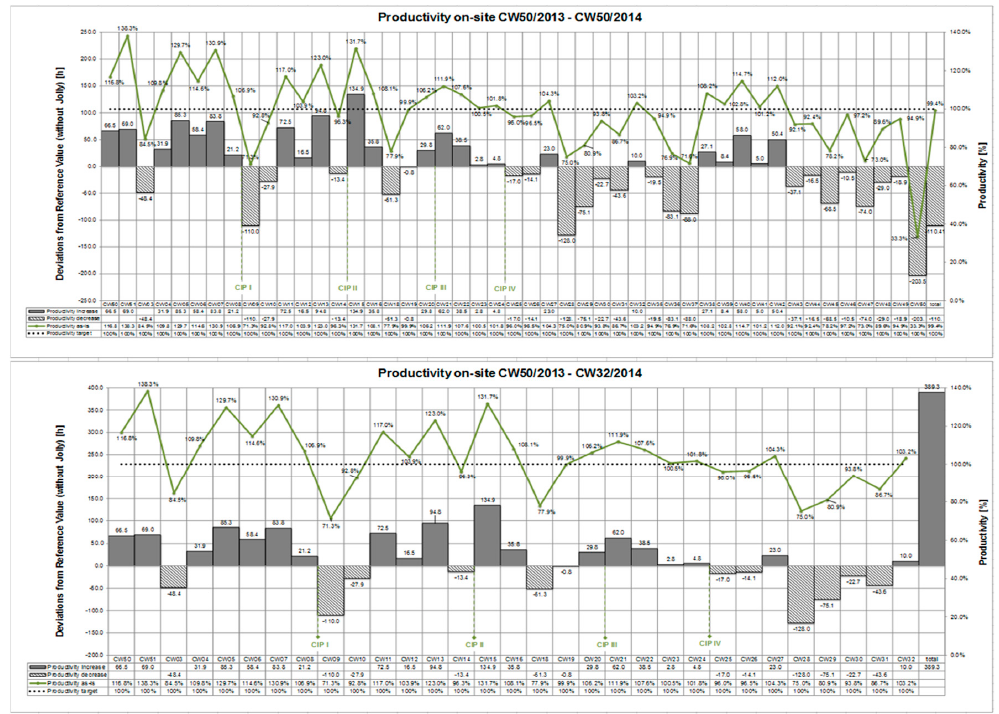
Figure 8. ( Upper chart ) Deviation measurement throughout the entire study period (CW50-2013 until CW50-2014); ( lower chart ) deviation measurement during the application of the CIP-workshops (CW50-2013 until CW32-2014).